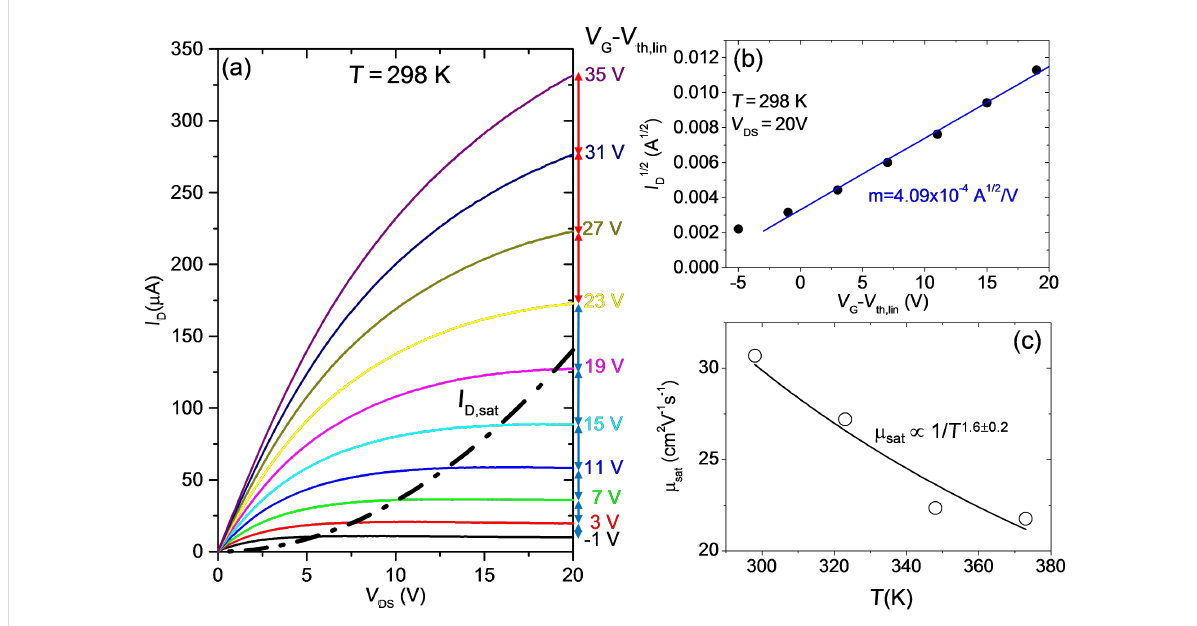
Figure 8: (a) Output characteristics ( I D − V DS ) for different gate bias values from − 56 to 0 V at T = 298 K. (b) Plot of I D1/2 vs V G − V th,lin for V DS = 20 V and linear fit of the data. (c) Saturation mobility μ sat vs temperature.